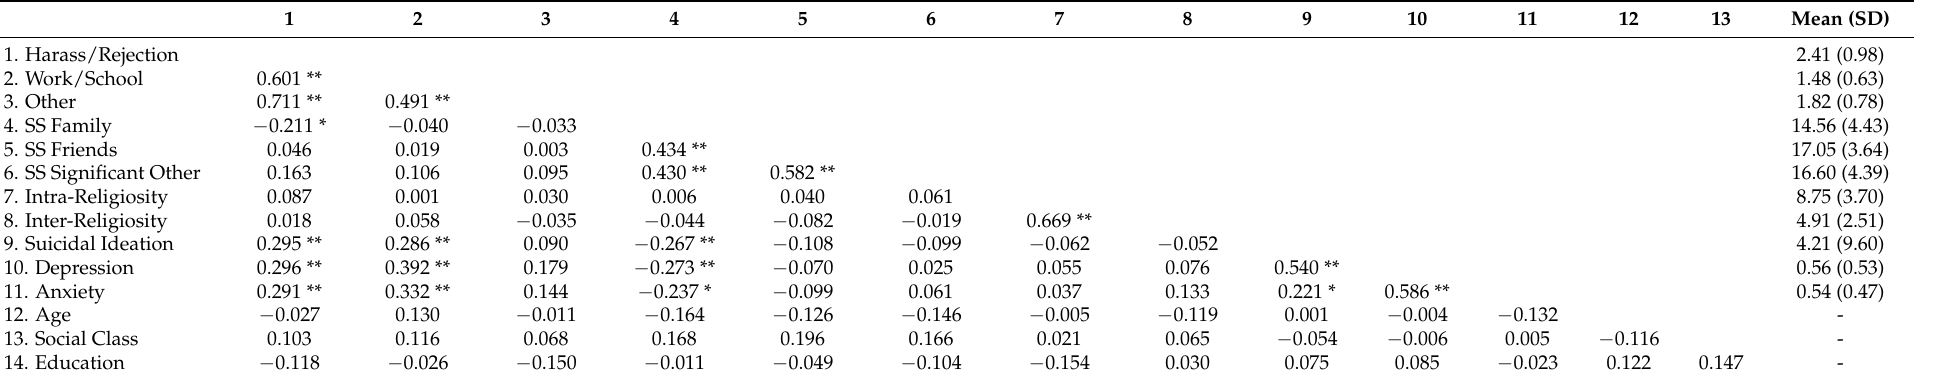
Table 2. Correlation matrix with study variable means and